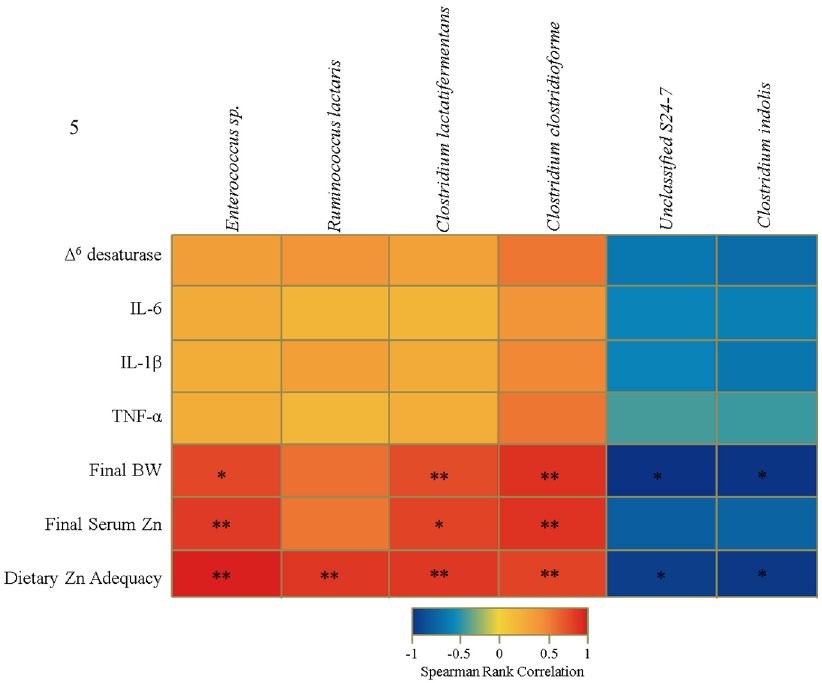
Figure 5. Heat map describing a set of Spearman correlations, independent of treatment group, between the relative abundance of different operational taxonomic units (OTUs) and select biological indicators of Zn status. The color indicator ranges from a perfect negative correlation ( − 1, blue) to a perfect positive correlation (1, red) (* p < 0.05, ** p < 0.01, ANOVA).